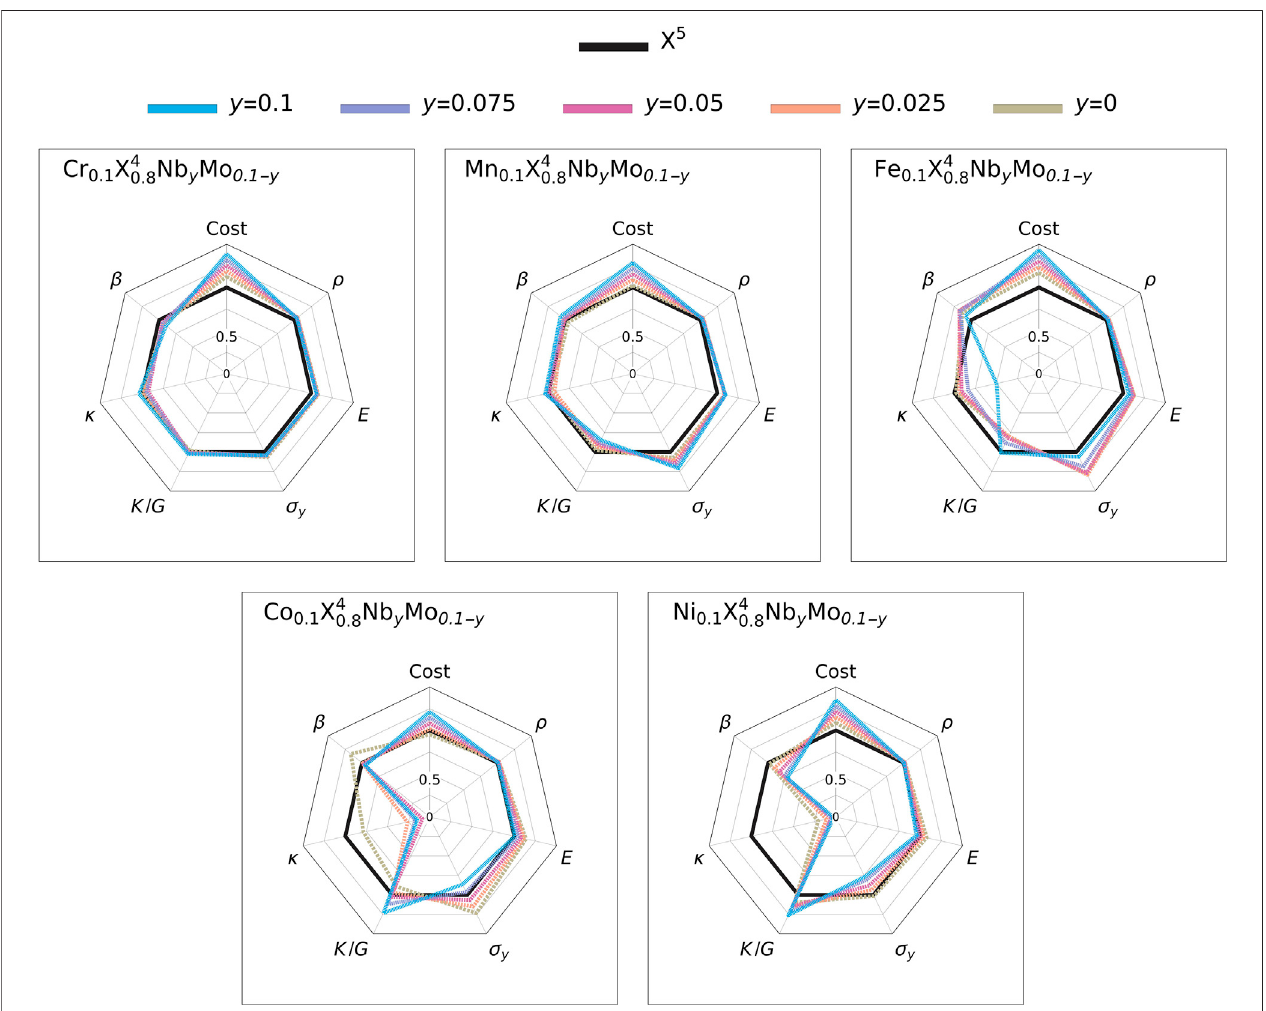
FIGURE 5| Composition dependence ofmaterial propertiesof non-equimolar six- and seven-principal-elements high-entropy alloys, shown by their ratio to those of CrMnFeCoNi (X 5 ), at T (cid:1) 1000 K.